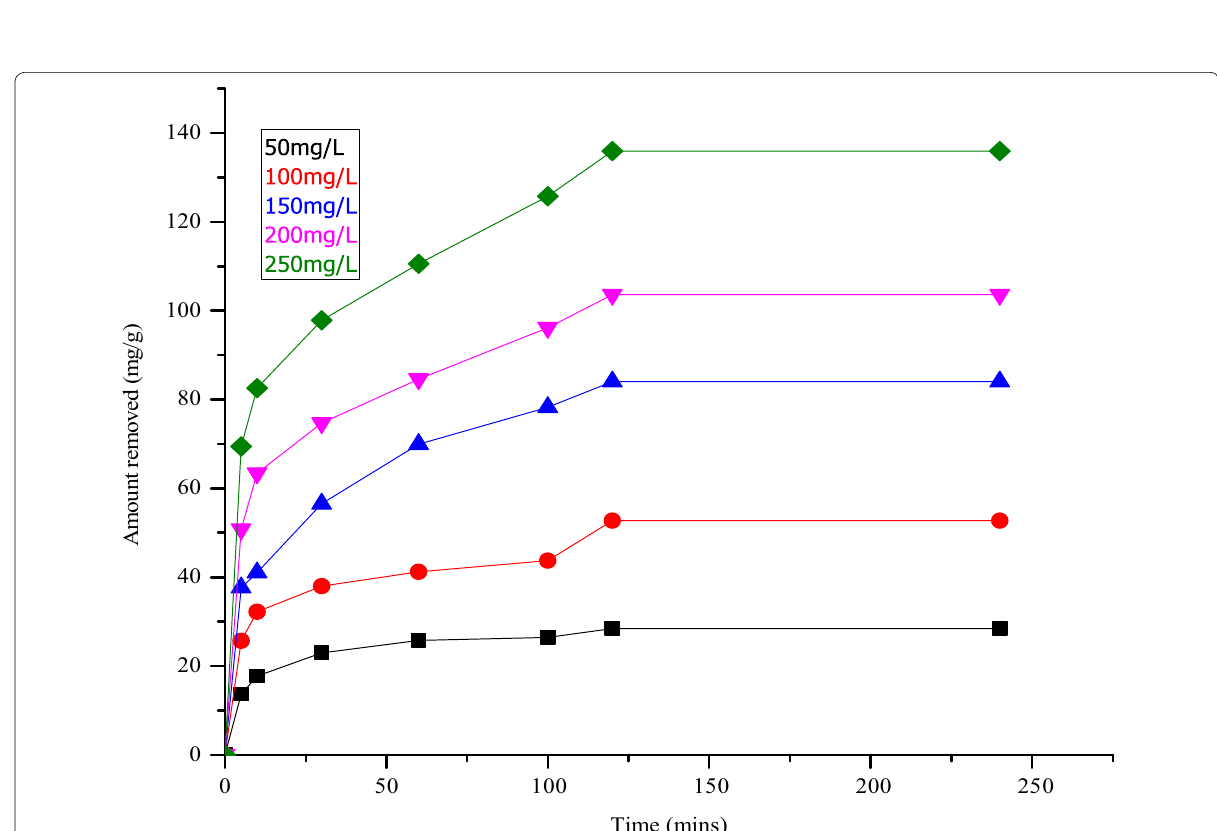
Fig. 3 Graphs of agitation time and pollutant concentrations on adsorption of Cd(II) at pH